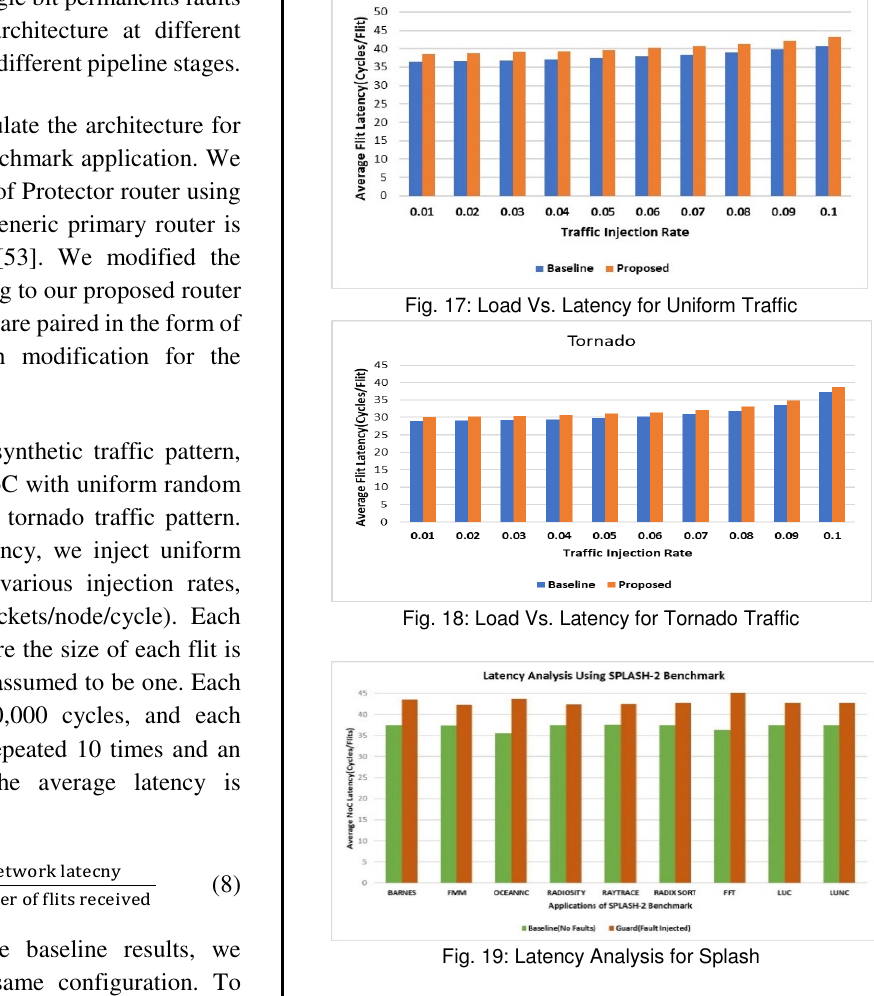
Fig. 19: Latency Analysis for